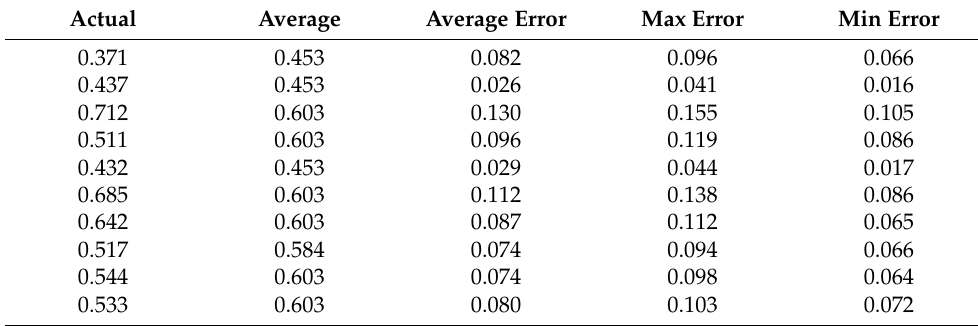
Table A160. Set 3, trials 1–10 data (average actual PR values).